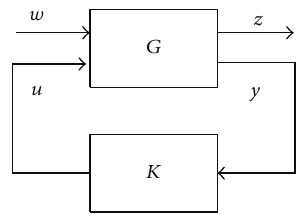
Figure 3: Standard 𝐻 ∞ -configuration.